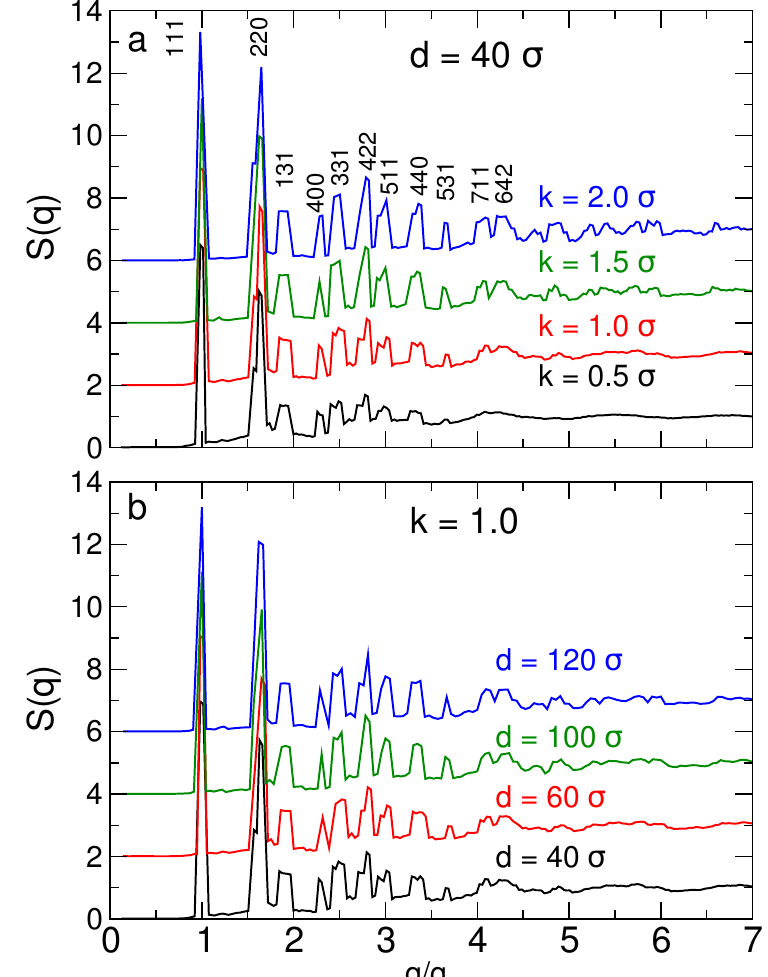
Figure 4. The structure factor S ( q ) for the cubic diamond lattice. ( a ) The structure factor for different DNA stiffness values. We label peaks by their corresponding Miller indices, known for the cubic diamond lattice. For stiffer DNA, the specific peaks of S ( q ) can be discerned for larger values of q / q 0 than for flexible DNA. In this sense, the stiffer DNA results in a better structured lattice. ( b ) The structure factor for different NP sizes. The effect of changing NP size on the structure is less pronounced than changing the DNA stiffness. For clarity of the figure, data are shifted